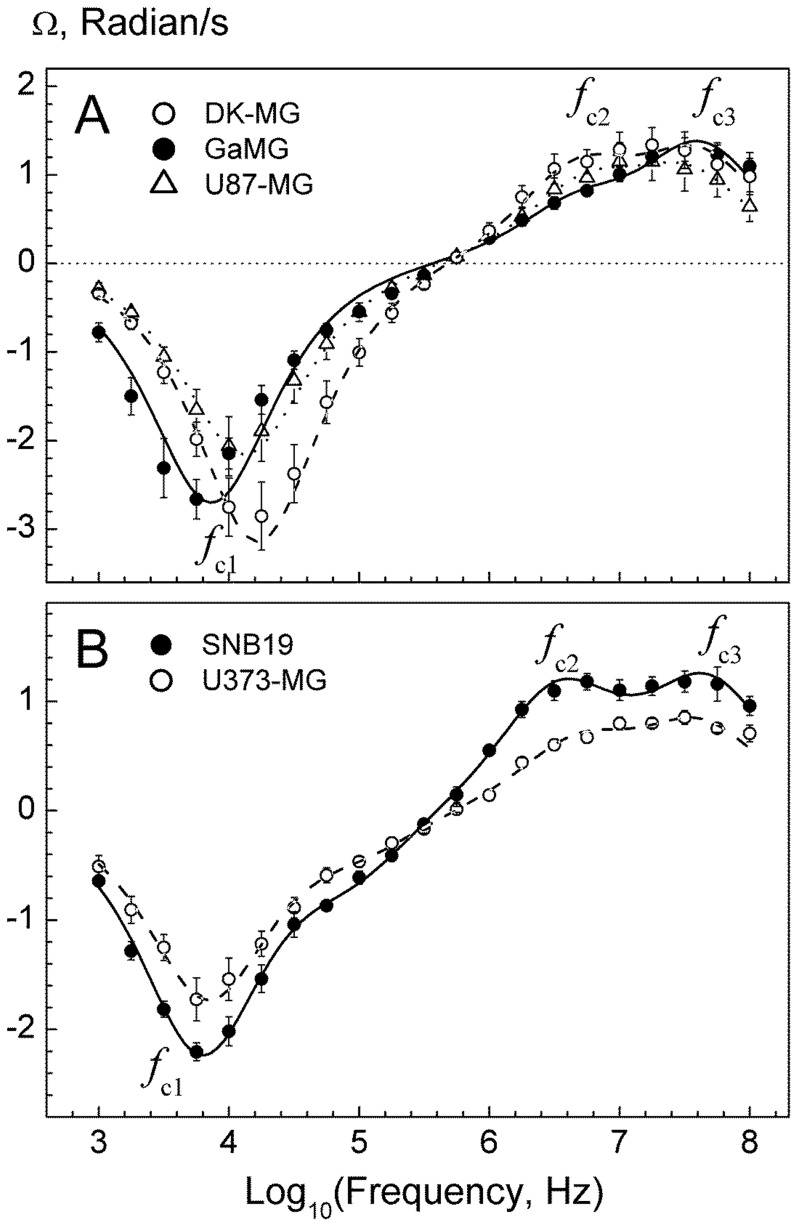
Rotation spectra of 5 GBM lines measured in isotonic 300-mOsm inositol solutions of the same conductivity of 50 µS/cm.Each spectrum (symbols) is the mean (±SE) of 8–10 single cell measurements. Curves are best fits with a double or triple Lorentzian function (Eq. 1). The fitted parameters are given in Table S1. The f
ci symbols denote three ROT peaks dominated by the plasma membrane charging (f
c1), and by the polarization of the cytosol and cell nucleus (f
c2 and f
c3).